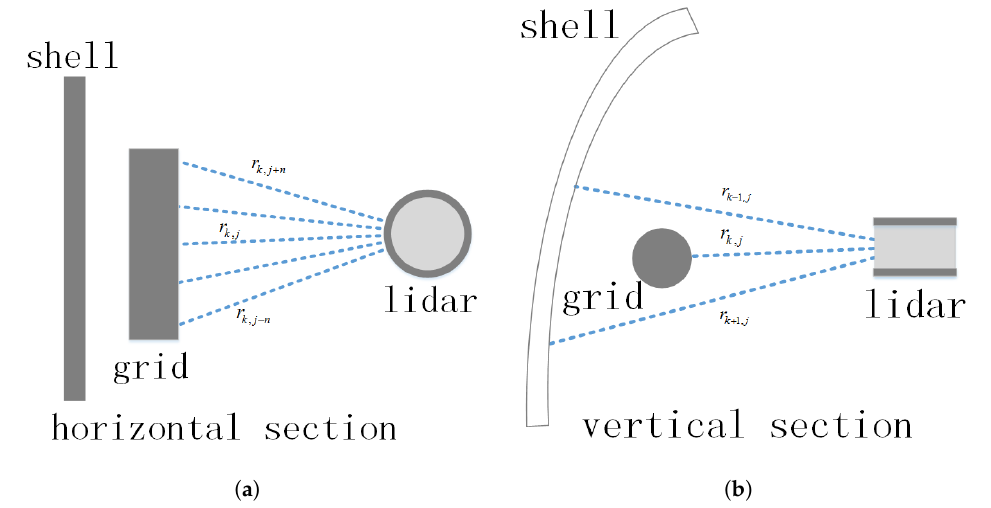
Figure 4. Schematic diagram of the shell feature extraction algorithm. ( a ) is a horizontal section view of a spatial grid structure containing vertical horizontal sections. ( b ) is a vertical section view of a spatial grid structure containing vertical horizontal sections. The blue dotted lines are the lights from the lidar scan points.